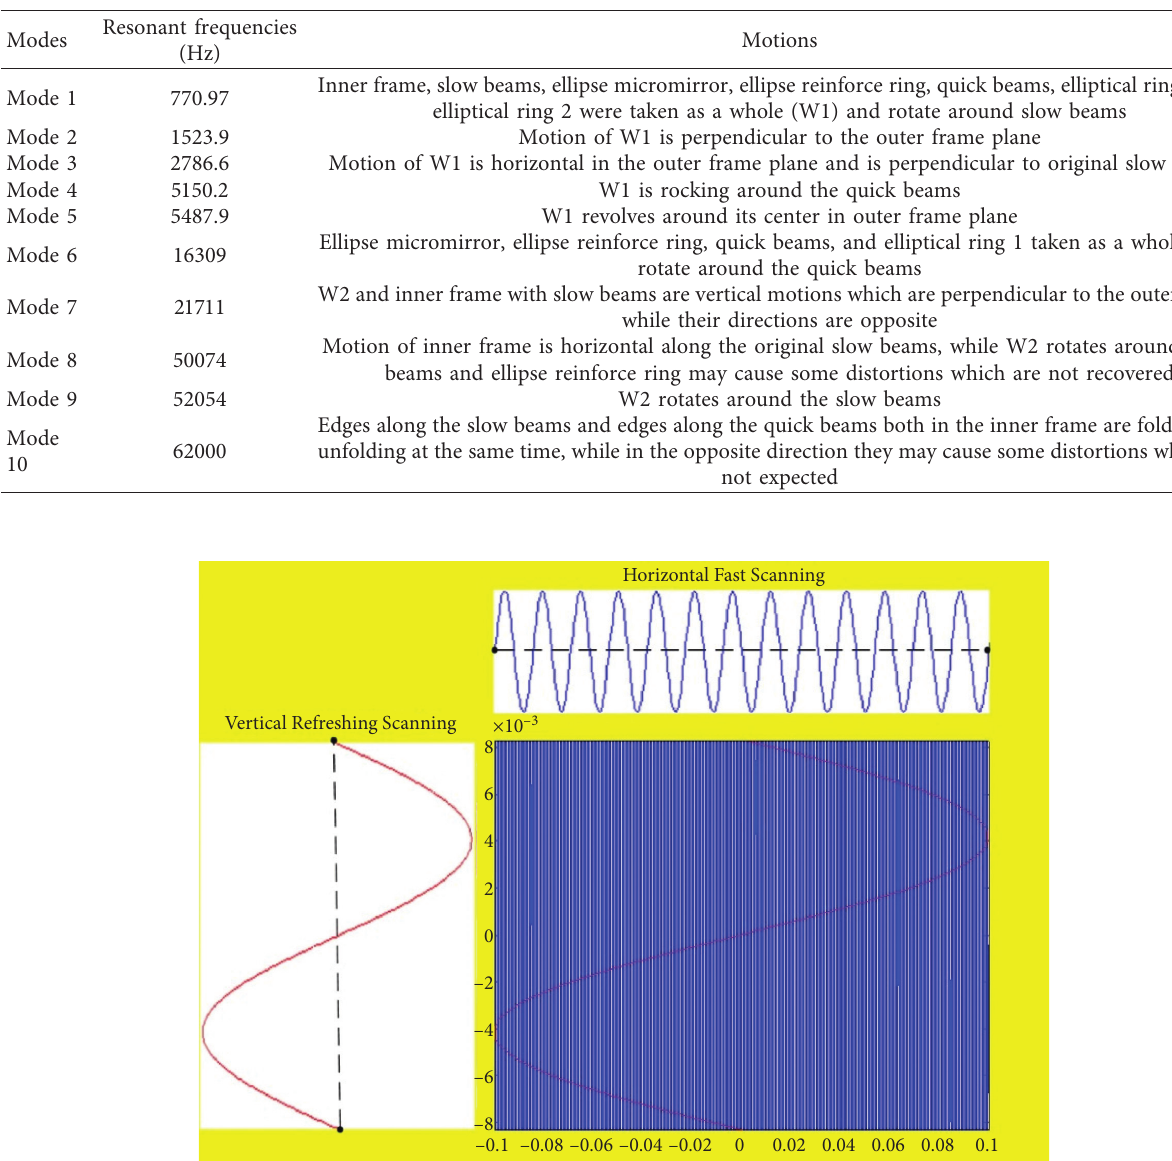
Figure 2: Ten resonant modes of electromagnetic micromirror. (a) Mode 1. (b) Mode 2. (c) Mode 3. (d) Mode 4. (e) Mode 5. (f) Mode 6. (g) Mode 7. (h) Mode 8. (i) Mode 9. (j) Mode Table 2: Characters of modal analysis.